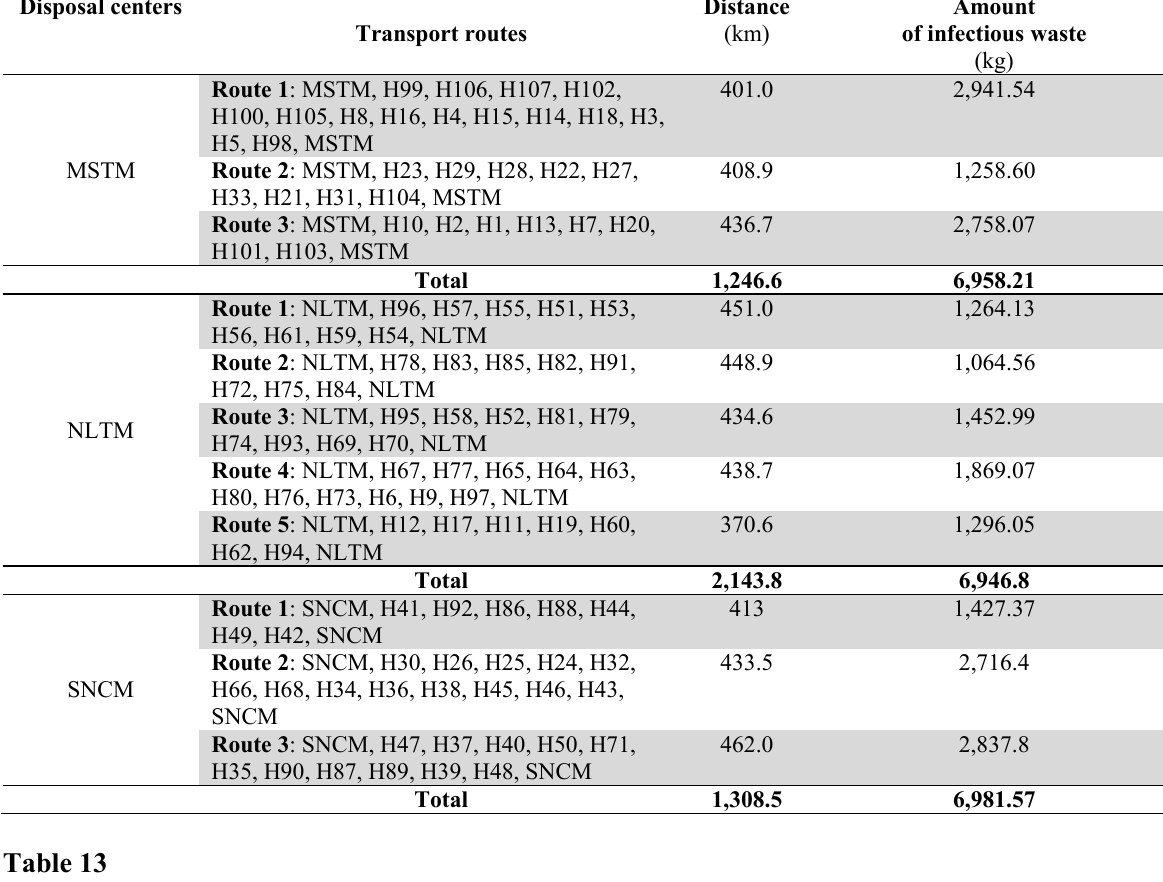
Details of computational results for the actual problems using HGA Disposal centers